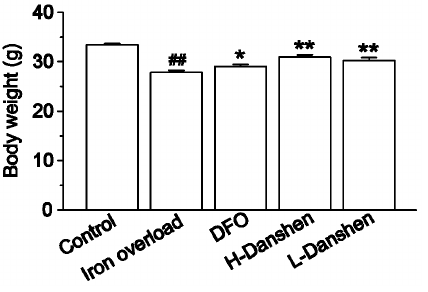
Figure 2. Effects of Danshen injection on body weight. Body weights of mice in the control, iron overload, DFO, H-Danshen and L- Danshen groups observed at day 14 of the experiment. Data are presented as means 6 S.E.M of 15 animals per group. *P , 0.05, **P , 0.01, compared with iron overload group; ## P , 0.01, compared with control